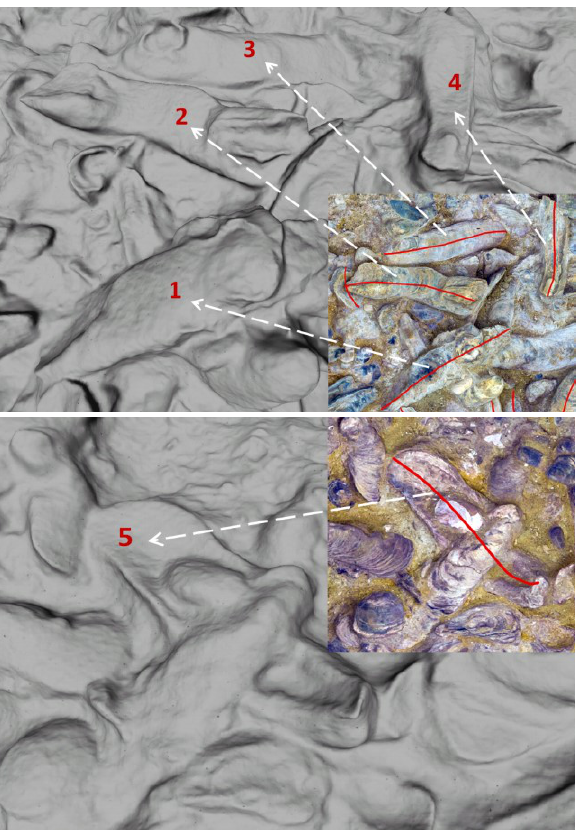
Figure 6. Visual inspection of encrustation (mesh model and orthophoto).